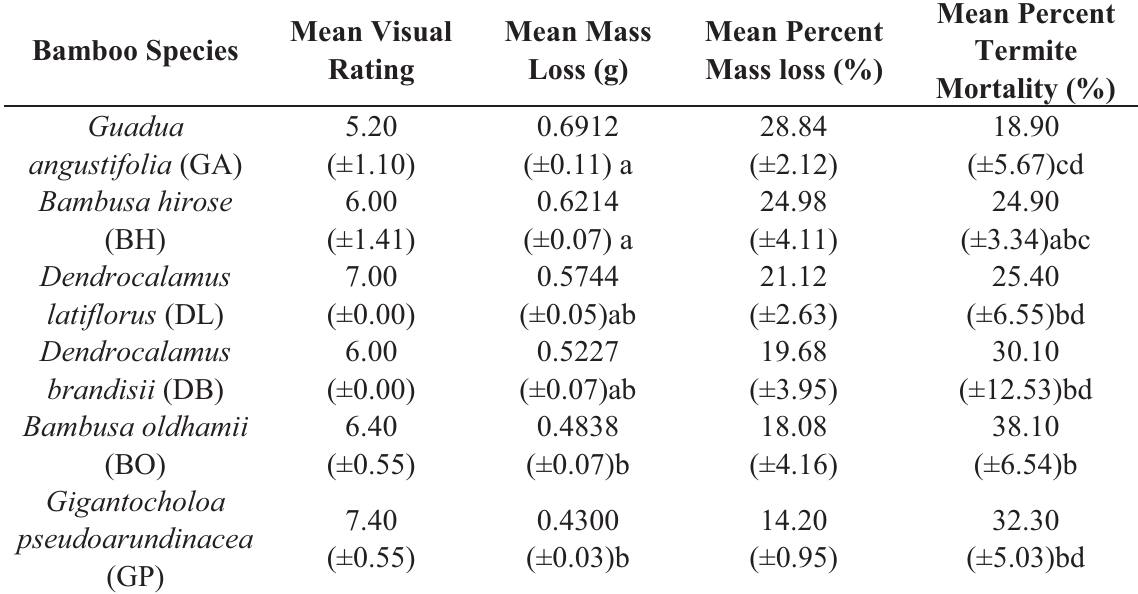
Table 1. Summary of results for C. formosanus from no-choice test. ( a Values in parentheses are standard deviations; means within a column followed by the same letter are not significant at the 5% level (one way ANOVA, Tukey’s HSD— SAS 9.2), Rating: